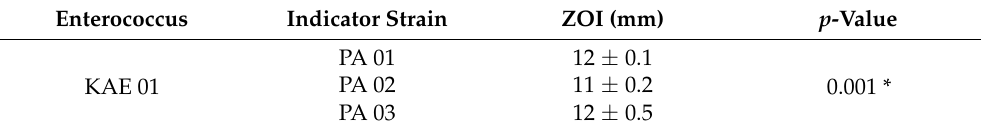
Table 1. Antimicrobial activity of purified enterocin KAE01 against P. aeruginosa